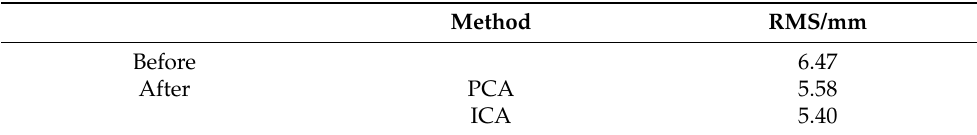
Figure 7. RMS reduction percentage of residual time series after ICA filtering. Table 2. Mean RMS error before and after PCA/ICA filtering of GPS